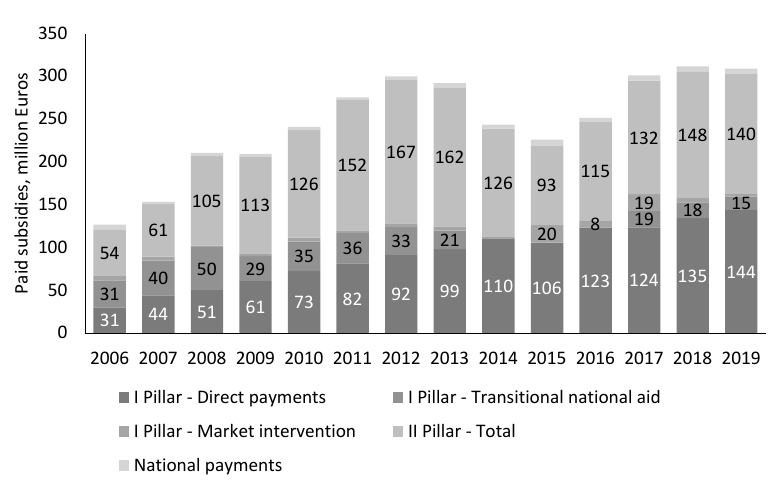
Fig. 2. Paid agricultural subsidies in Estonia, million Euros, 2006‒2019. Source: Estonian Ministry of Rural Affairs